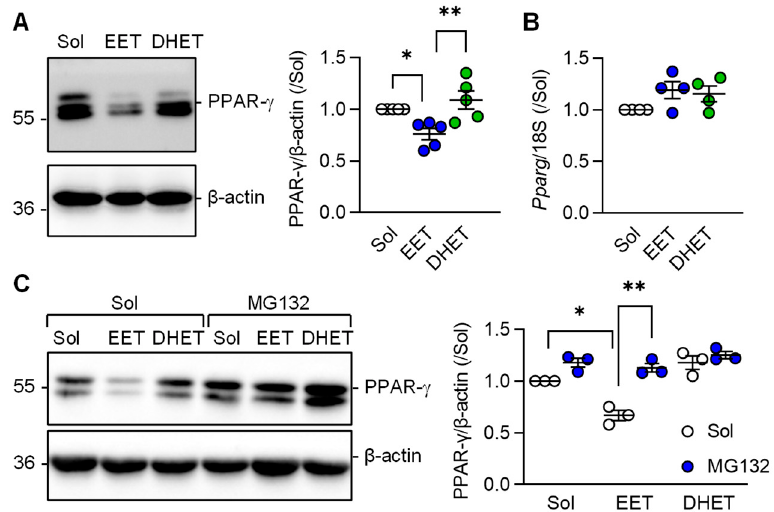
Figure 5. Regulation of PPAR- γ levels by 11,12-EET and 11,12-DHET in M2c polarized macrophages from wild-type mice. ( A ) Impact of solvent (Sol, 0.1% DMSO), 11,12-EET or 11,12-DHET (both 1 µmol/L; 30 min prior to TGF- β ) on the expression of PPAR- γ in M2c polarized macrophages ( n = 5 independent experiments, Kruskal–Wallis test followed and Dunn’s multiple comparisons test). ( B ) PPAR- γ mRNA levels in cells treated with solvent, 11,12-EET and 11,12-DHET as in panel a ( n = 4 independent experiments, Kruskal–Wallis test followed and Dunn’s multiple comparisons test). ( C ) Consequence of inhibiting protein degradation using MG132 (2 µmol/L, 1 h pretreatment) on PPAR- γ protein stability in M2c polarized macrophages treated with solvent (Sol, 0.1% DMSO), 11,12-EET or 11,12-DHET (both 1 µmol/L) 1 h prior to the addition of TGF- β ( n = 3 independent experiments, two way ANOVA and Sidak‘s multiple comparisons test). * p < 0.05, ** p < 0.01.